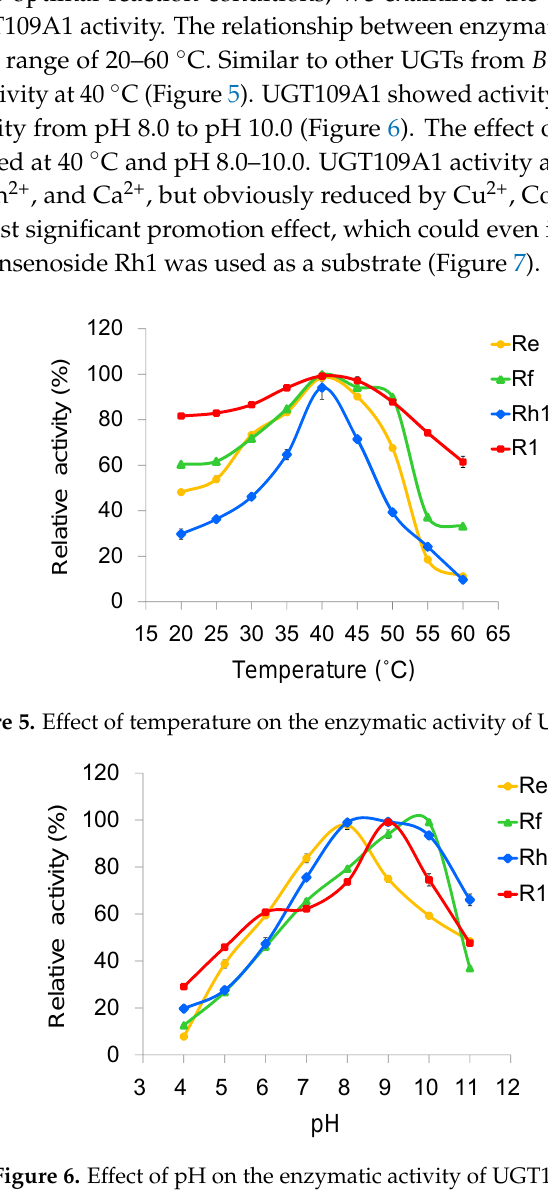
Figure 7. Effect of metal ions on the enzymatic activity of UGT109A1. 3. Discussion Glycosylation catalyzed by UGTs is usually the last step of natural product biosynthesis, but it plays a vital role in generating bioactive natural compounds [28]. In the process of ginsenoside biosynthesis, UGTs catalyze the transfer of glycosyl residues from activated sugars to the aglycones, and thus regulate properties of ginsenosides, such as bioactivity, solubility, and stability. Moreover, glycosylation also determines the diversity of ginsenosides. Up to now, several UGTs have been characterized in P. ginseng , which exhibit strict substrate selectivity and specificity [11–13]. It has been reported that UGTs from microbes possess a more open and larger acceptor binding pocket than